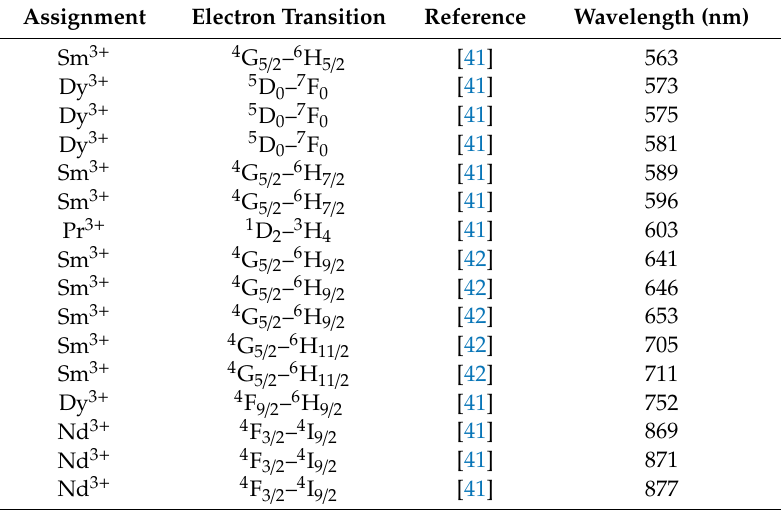
Figure 9. The luminescence spectrum of hydroxylapatite from Muránska Dlhá Lúka measured with blue laser on the Raman spectrometer. Table 6. The luminescence spectrum band assignment of hydroxylapatite from Mur á nska Dlh á L ú